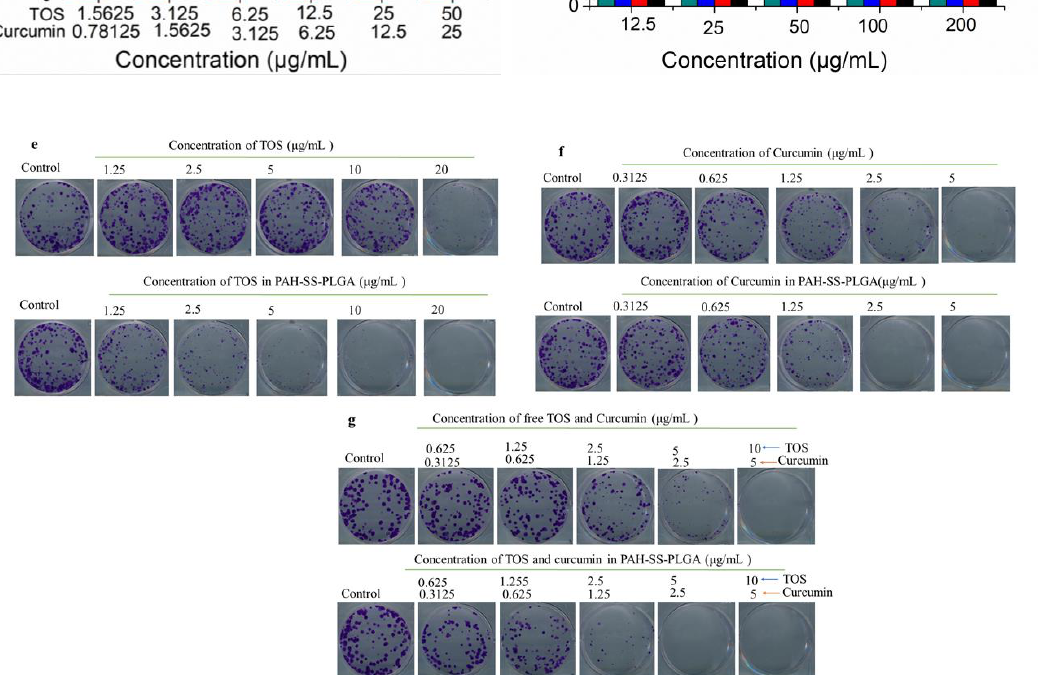
Figure 4. MTT in vitro cytotoxcity results using PAN02 pancreatic cancer cells ( a ) free curcumin and curcumin-loaded micelles, ( b ) free TOS and TOS-loaded micelles, ( c ) a combination of TOS and curcumin, ( d ) PAH, PAH-Cit, PLGA-Cys and PAH-SS-PLGA, and ( e – g ) representative images of the crystal violet-stained colonies using PAN02 pancreatic cancer cells at different doses of free TOS and PAH-SS-PLGA-TOS, free curcumin and PAH-SS-PLGA-curcumin, and a combination of free TOS and curcumin and nanoformulated TOS / curcumin, respectively. Data are expressed as mean ± SD values (n = 3). (* p < 0.05, ** p < 0.01, *** p <